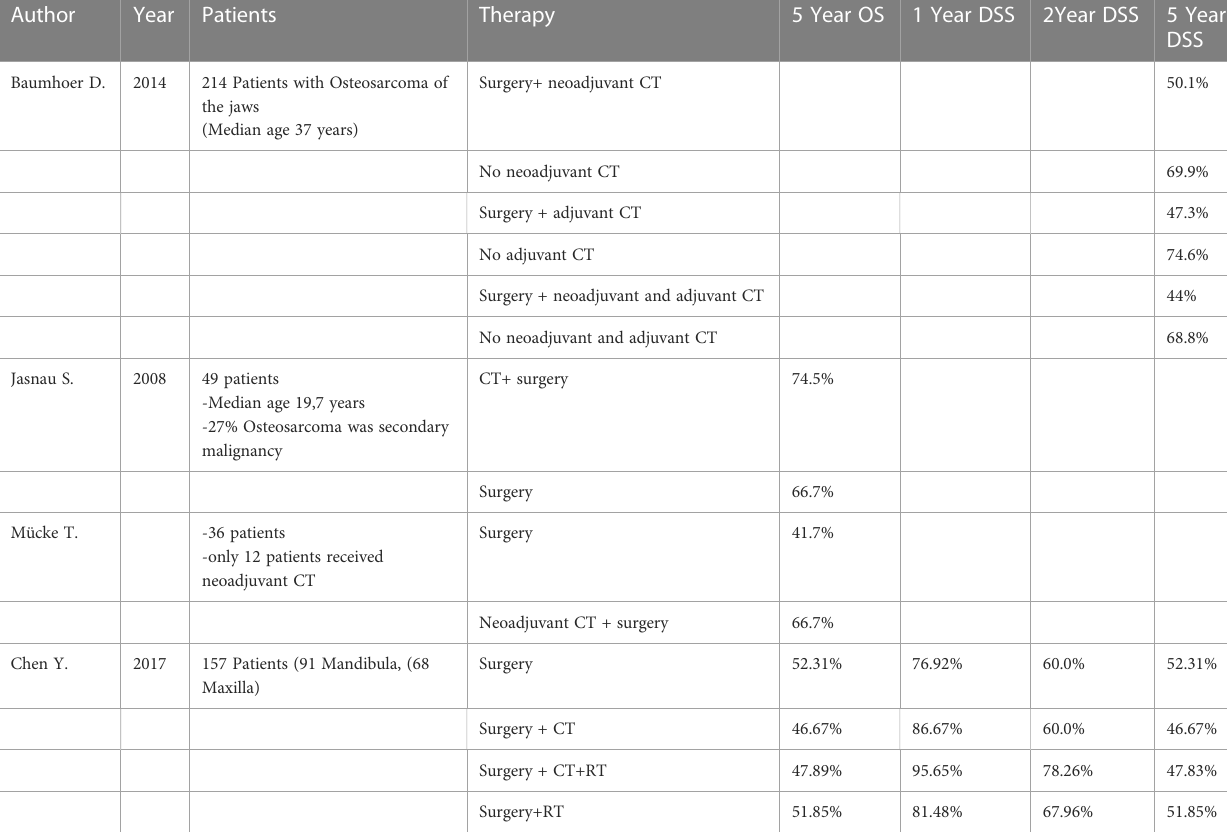
TABLE 4 Survival rate related to therapeutic intervention in COS patients.